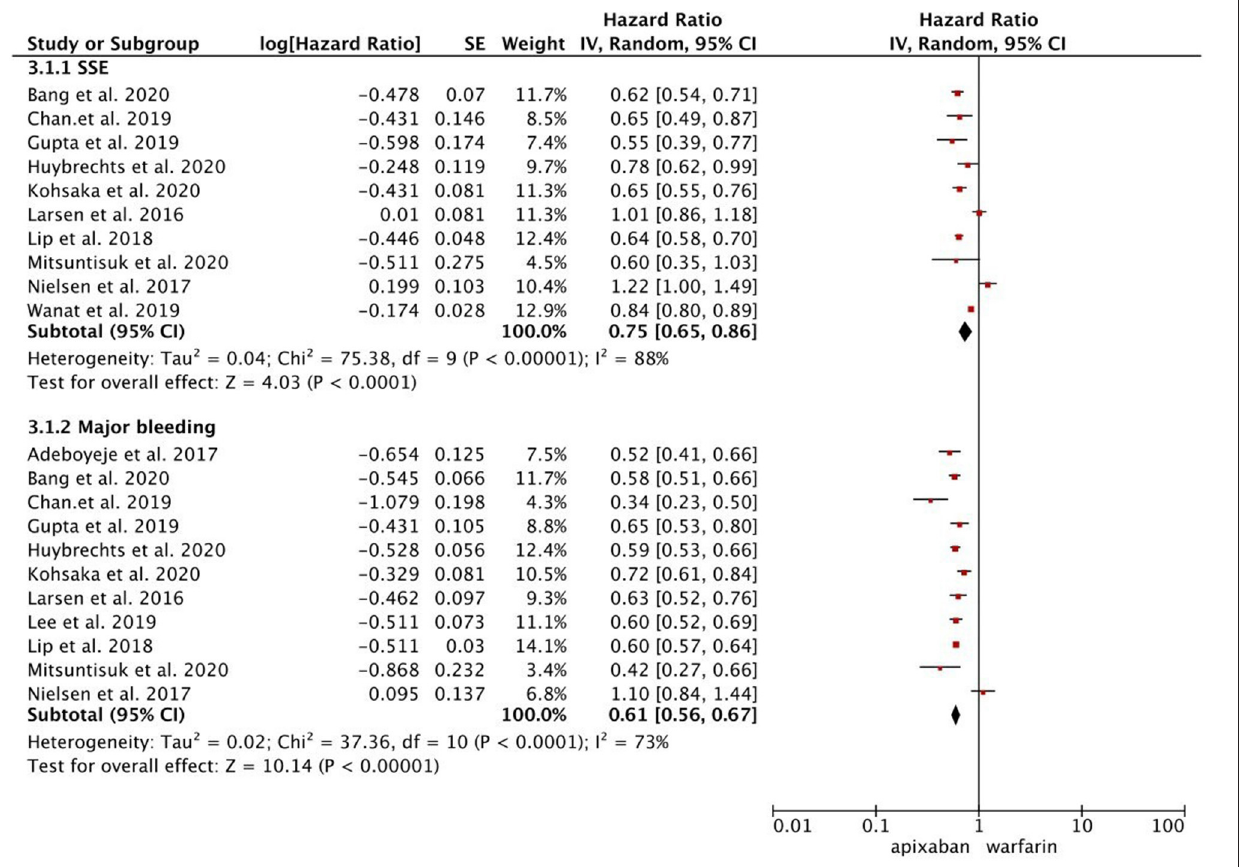
FIGURE 3 | Comparing the primary outcomes including SSE and MB of apixaban vs. warfarin. SSE, stroke or systemic embolism; MB, major bleeding; HR, hazard ratio; CI, confidence interval; SE, standard error; IV, inverse of the